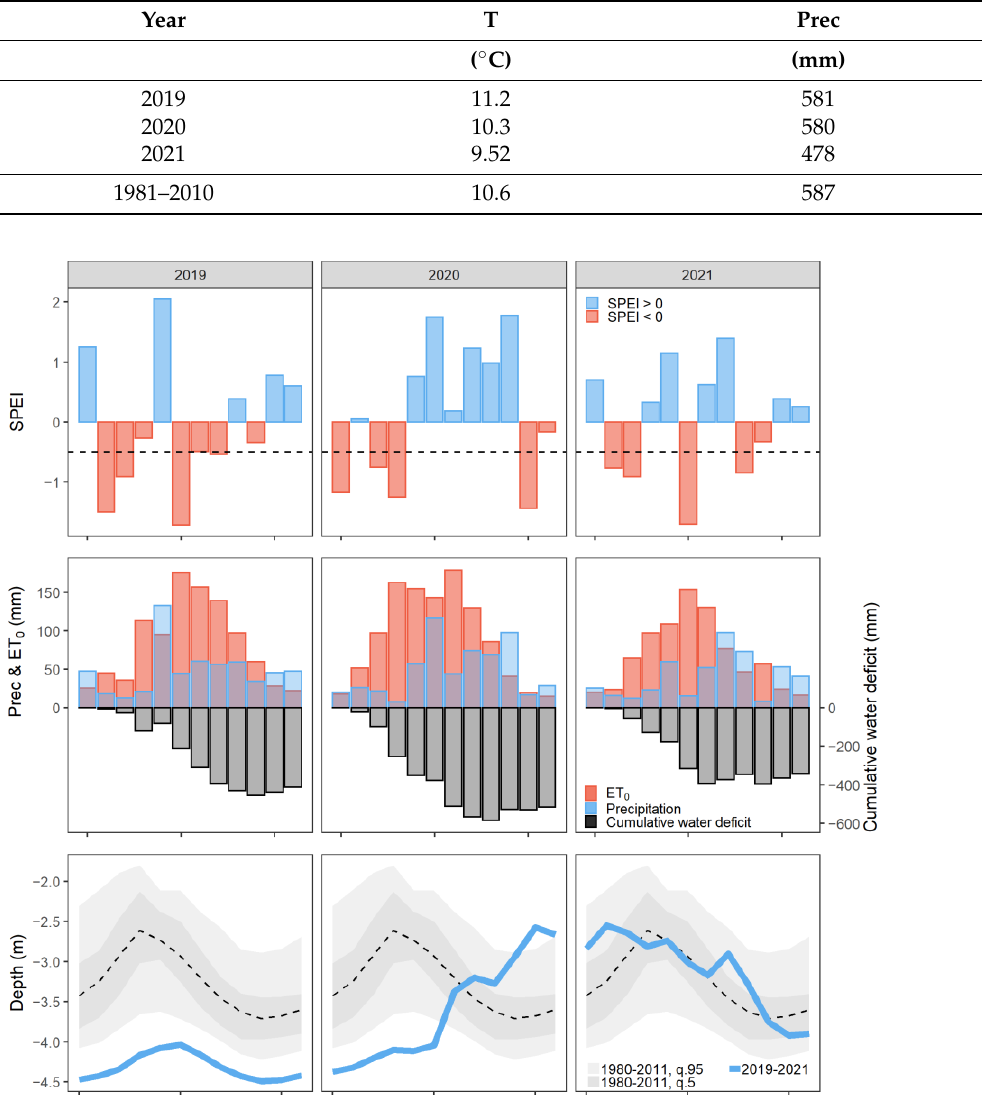
Table 1. Average yearly temperature (T) and total yearly precipitation (Prec) on the studied locality.